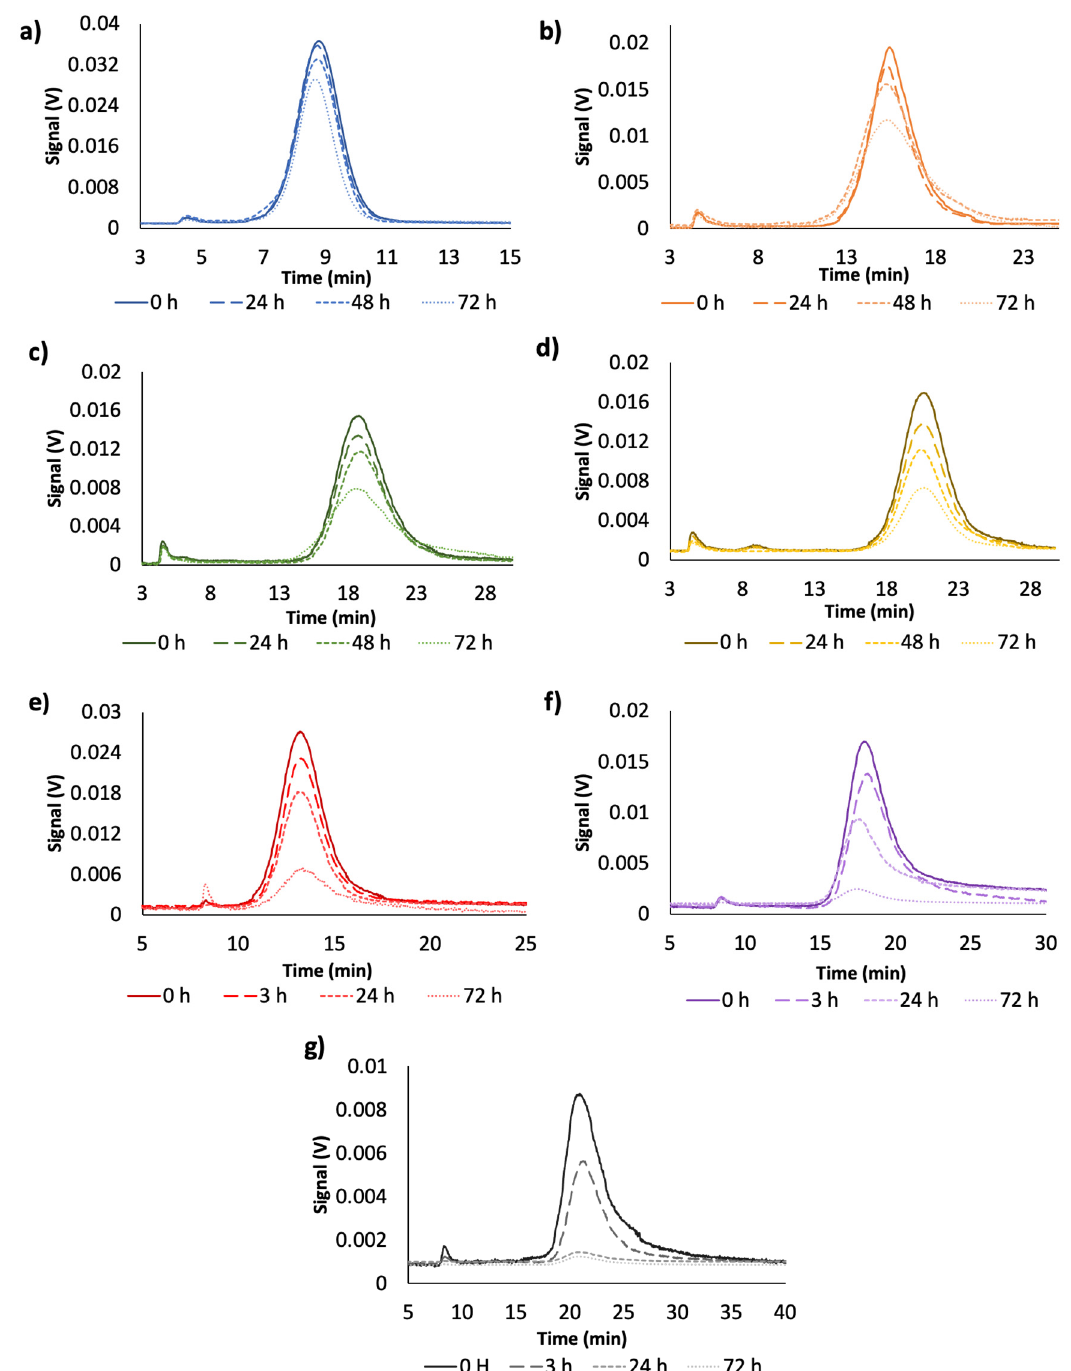
Figure 3. Fractograms of the evolution of nanoparticles dispersions as function of dilution preparation time for different sizes ( a ) AuNPs 20 nm, ( b ) AuNPs 40 nm, ( c ) AuNPs 60 nm, ( d ) AuNPs 80 nm, ( e ) AgNPs 20 nm, ( f ) AgNPs 40 nm and ( g ) AgNPs 60 nm.